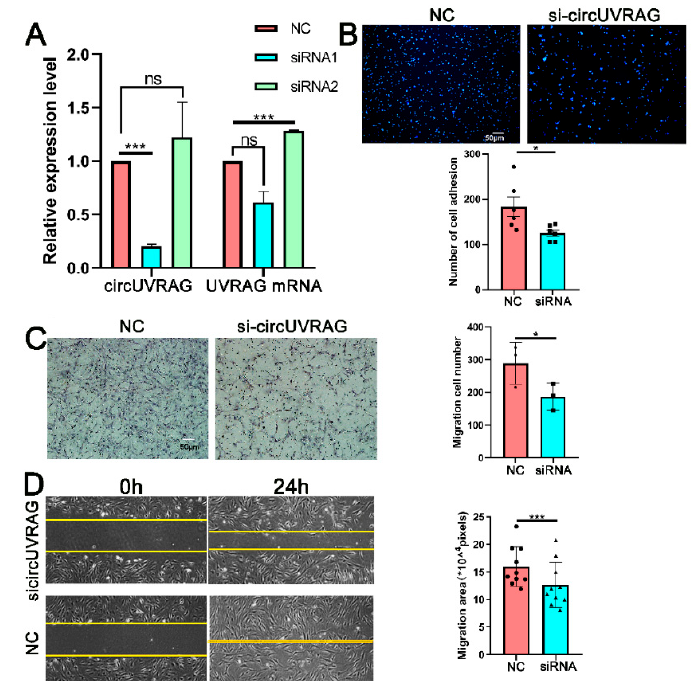
Figure 3. Knockdown of circUVRAG inhibits VSMC adhesion and migration. ( A ). Two small interference RNA (siRNA) sequences targeting the back-splicing junction are designed to specifically reduce circUVRAG. SiRNA1 effectively reduced the expression of circUVRAG by 70% without affecting the expression of linear UVRAG mRNA ( n = 3). ( B ). Knockdown of circUVRAG inhibits VSMC adhesion ( n = 6). ( C , D ). Transwell assay ( n = 3) ( C ) and wound healing assay ( n = 10) ( D ) demonstrate that knockdown of circUVRAG inhibits VSMC migration. Bar = 50 μ m, * p < 0.05, *** p < 0.001.